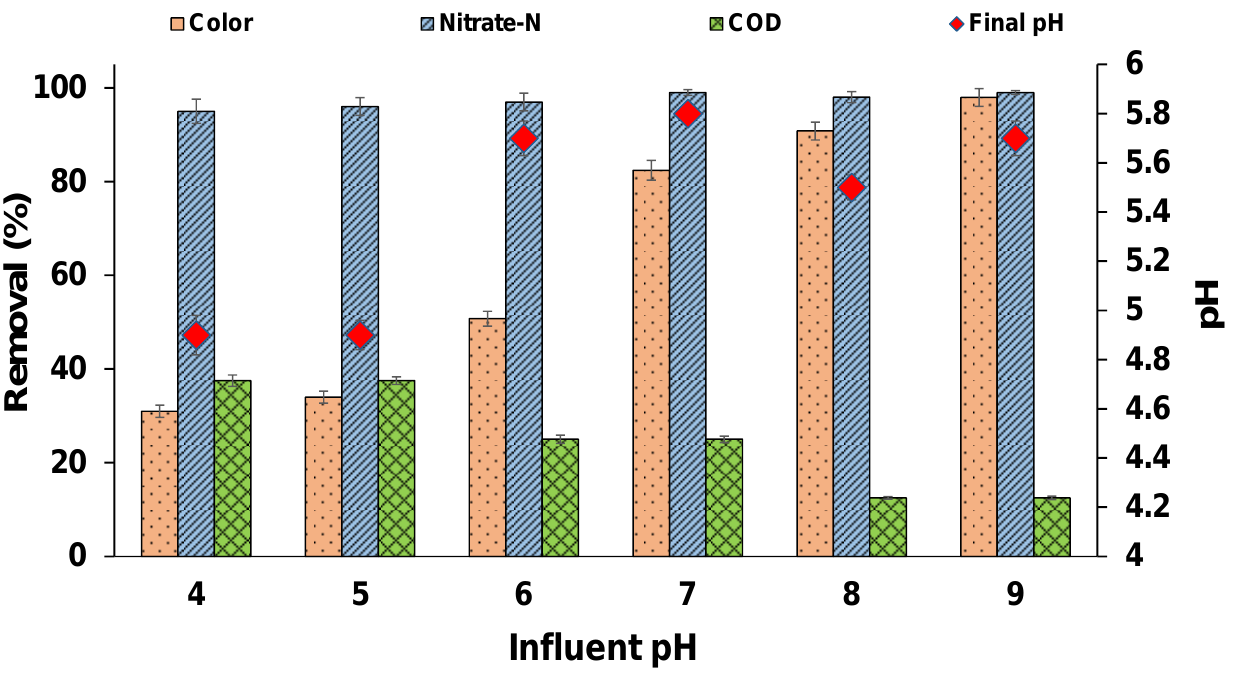
Figure 4. Effect of pH on MO decolourization (temperature: 30 ± 2 °C; volume: 150 mL; MLSS: 1 g/L; RPM: 110 ± 2; time: 96 h).